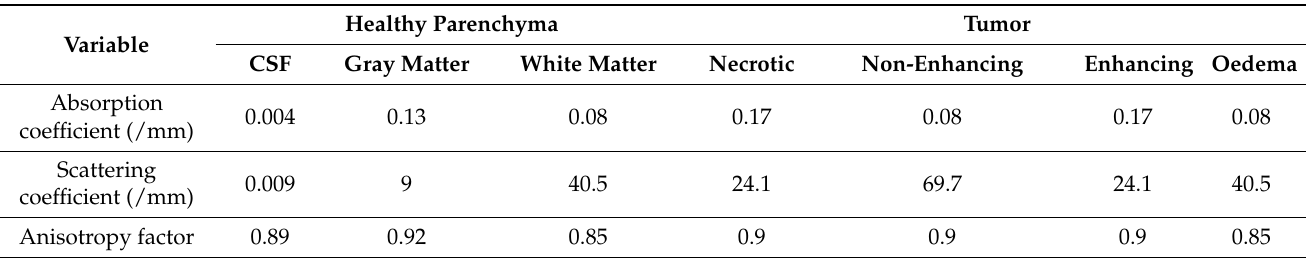
Table 1. Optical properties at 635 nm for the seven brain tissues considered in the study (issued from references [30–34]). The refractive index (RI) was the same for all subtypes of cerebral tissue (RI =